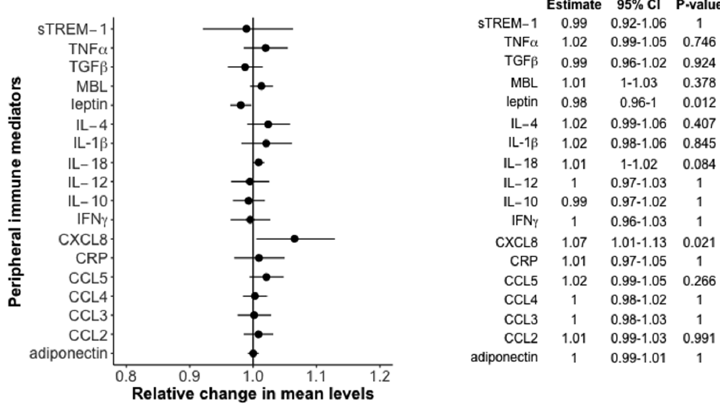
Figure 2. Relative change in mean levels of immune mediators with 95% confidence bands by 10 nmol/L increase in 25(OH)D levels in the newly diagnosed cohort—results from the full adjusted model. IL, interleukin; IFN γ , interferon gamma; TNF α , tumor necrosis factor alpha; TGF β , transforming growth factor beta; CRP, c ‐ reactive protein; MBL, mannose ‐ binding lectin; sTREM ‐ 1, soluble triggering receptor expressed on myeloid cells ‐ 1; CXCL, chemokine (c ‐ x ‐ c motif) ligand; CCL, chemokine (c ‐ c motif) ligand; CI, confidence interval.